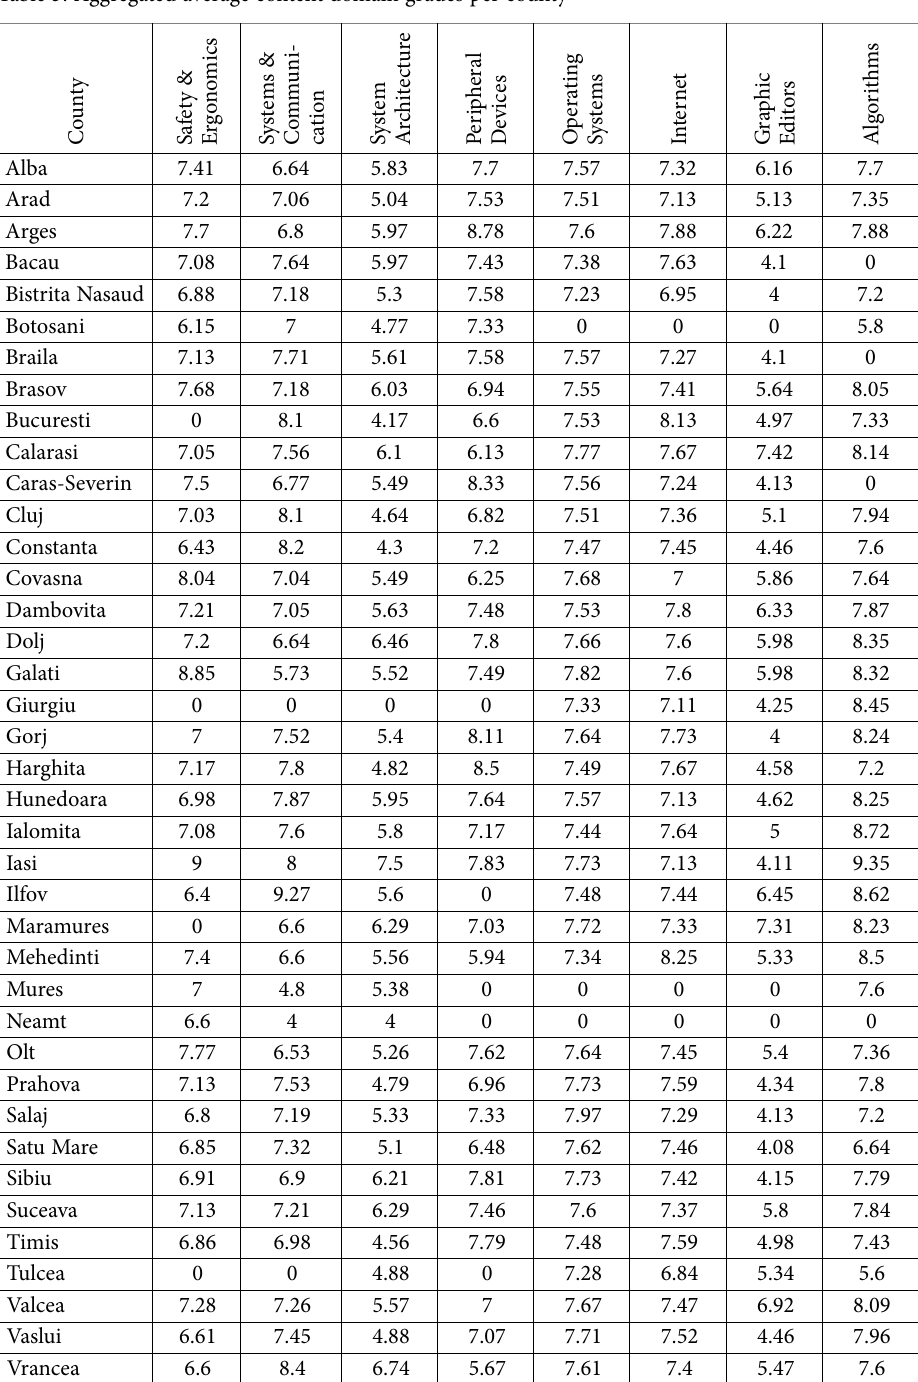
Table 3. Aggregated average content domain grades per